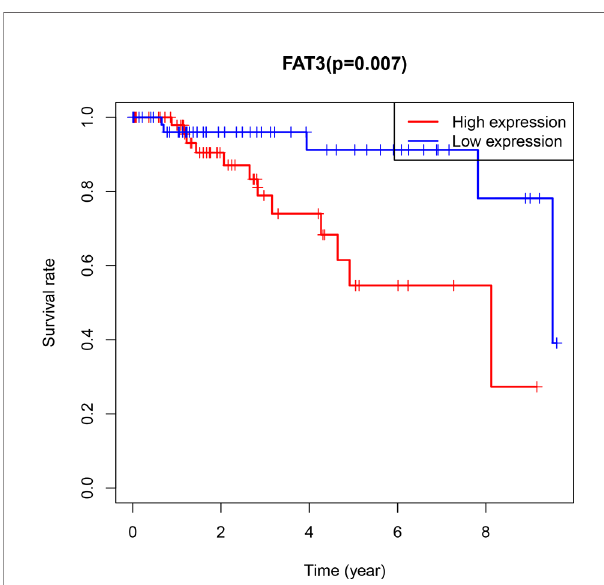
FIGURE 5 | Kaplan-Meier Diagram of FAT3 expression and prognosis in patients. Blue represents low expression, red represents high expression